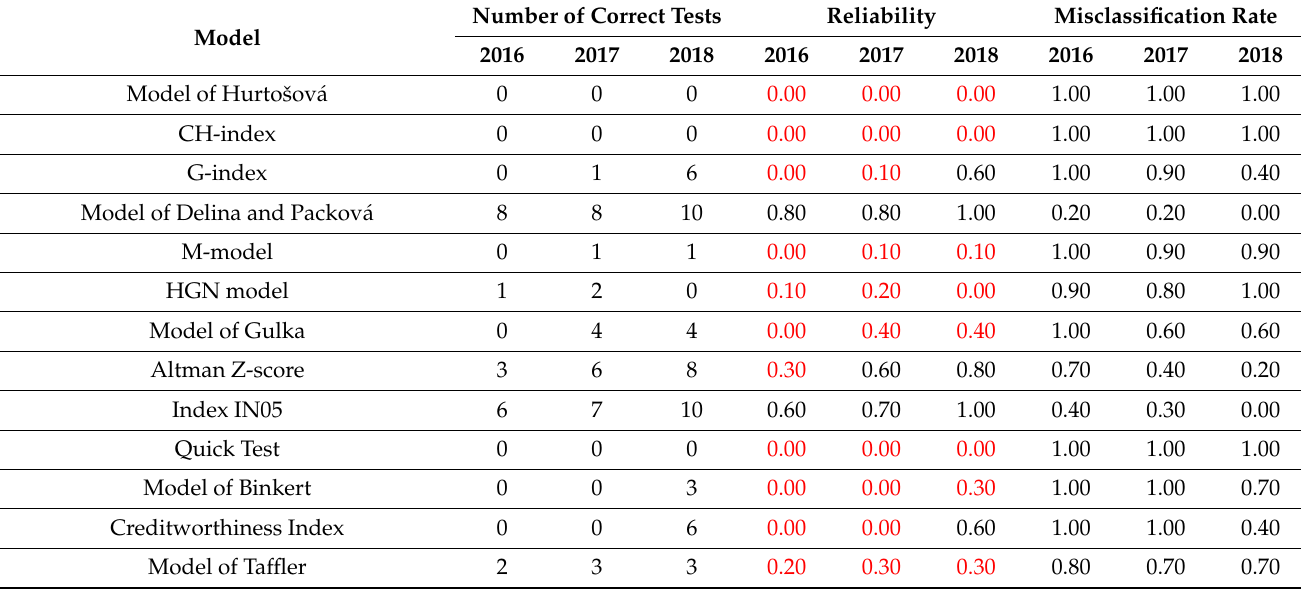
Table 7. Results of testing default prediction models on non-prosperous companies in tourism sector in 2016–2018.